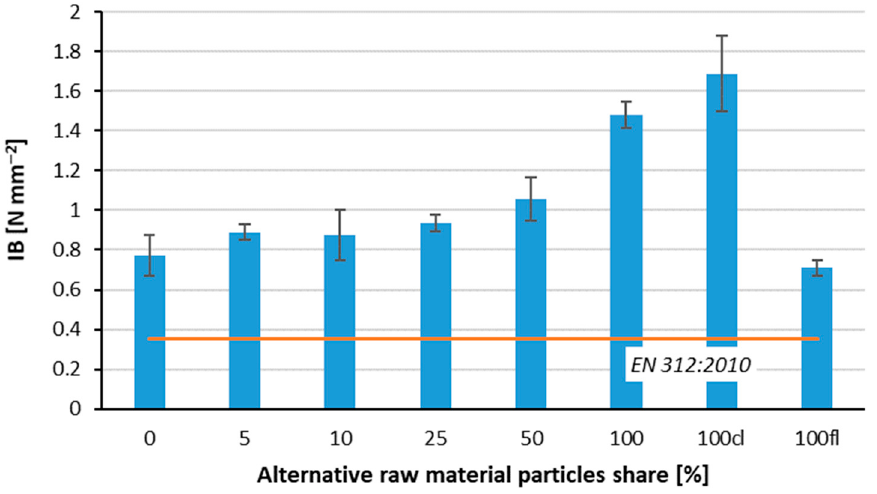
Figure 6. Internal bond of tested composites.